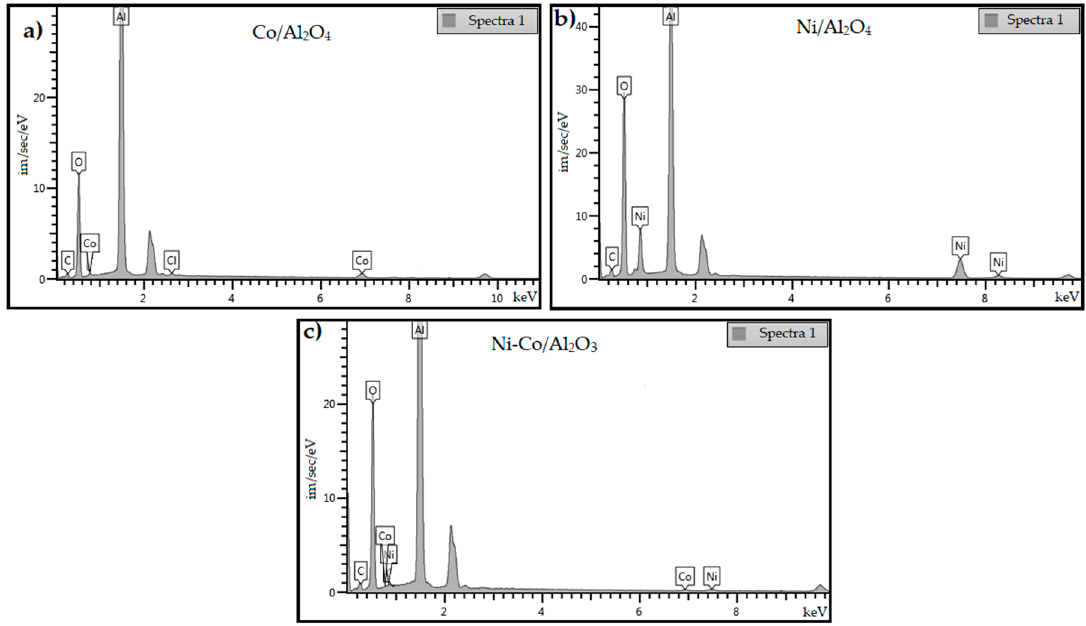
Figure 10. Spectra of Ni- and Co-based catalysts via SEM-EDX analysis ( a : for Co/Al2O4, b : for Ni/Al2O4, c : for Ni-Co/Al2O4).